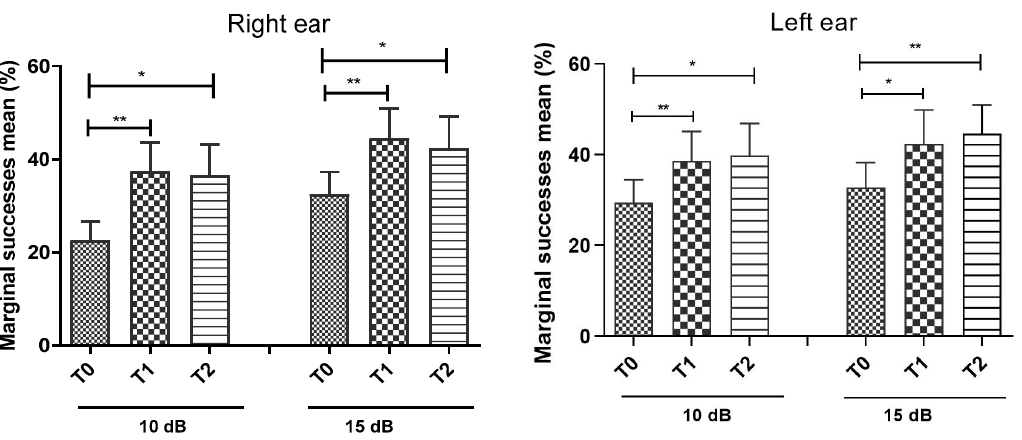
Figure 2. Representation of the marginal success means obtained in T0, T1 and T2 for an SNR of 10 and 15 dB in right ear (left panel) and left ear (right panel). * p < 0.05; ** p < 0.01.